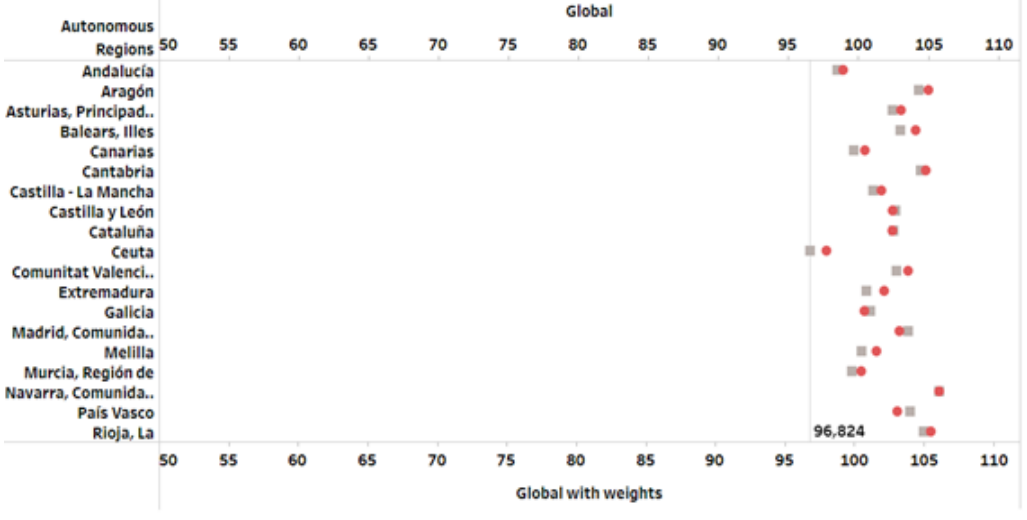
Figure 8. The ranking generated by the INE including the Table 13 weights. Table 14 displays the data used to create Figure 9. Figure 9 shows our ranking generated by ELECTRE III two-stage approach with thresholds on the indicators of the dimensions and with and without the different weights on the dimensions. For the bars interpretation of the image, it must first be noted that ELECTRE III only gives the ranking, so the first position (the best position) is the ranking number 1. Secondly, we observe that while in the solution without weights there were 14 positions in the ranking, when weights are introduced, they are reduced to 13. This is evidently due to the ties. The grey dots represent the ranking with weights and the red dots represent the ranking with all weights of the 9 dimensions equal to 1. This figure is also a self-elaborated image created by authors using INE data and Tableau Public software.